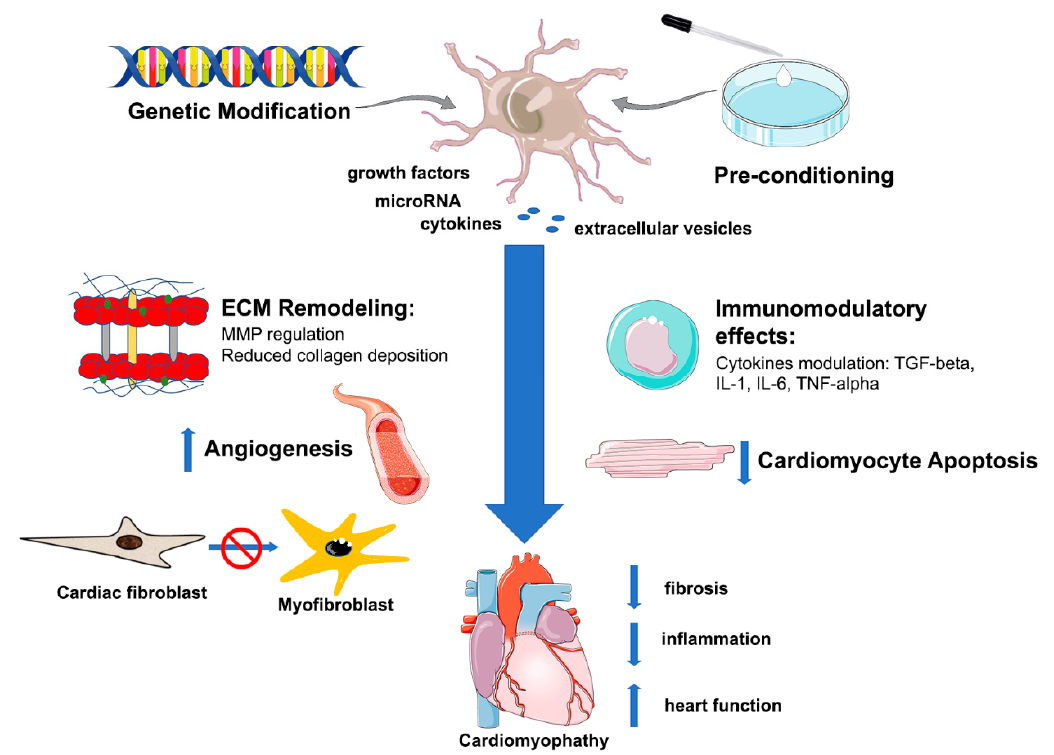
Figure 1. MSCs therapy in cardiomyopathy. MSCs release growth factors, microRNAs and cytokines, directly or in extracellular vesicles, which modulate different aspects of cardiomyopathies. MSCs reduce fibrosis by modulating MMPs, reducing collagen deposition and inhibiting the conversion of cardiac fibroblasts to myofibroblasts. MSCs also reduce inflammation, stimulate angiogenesis and reduce cardiomyocyte apoptosis. All of these factors result in cardiac function improvement, as observed in pre-clinical models. MMP: matrix metalloproteinases. Created using https://smart.servier.com/.